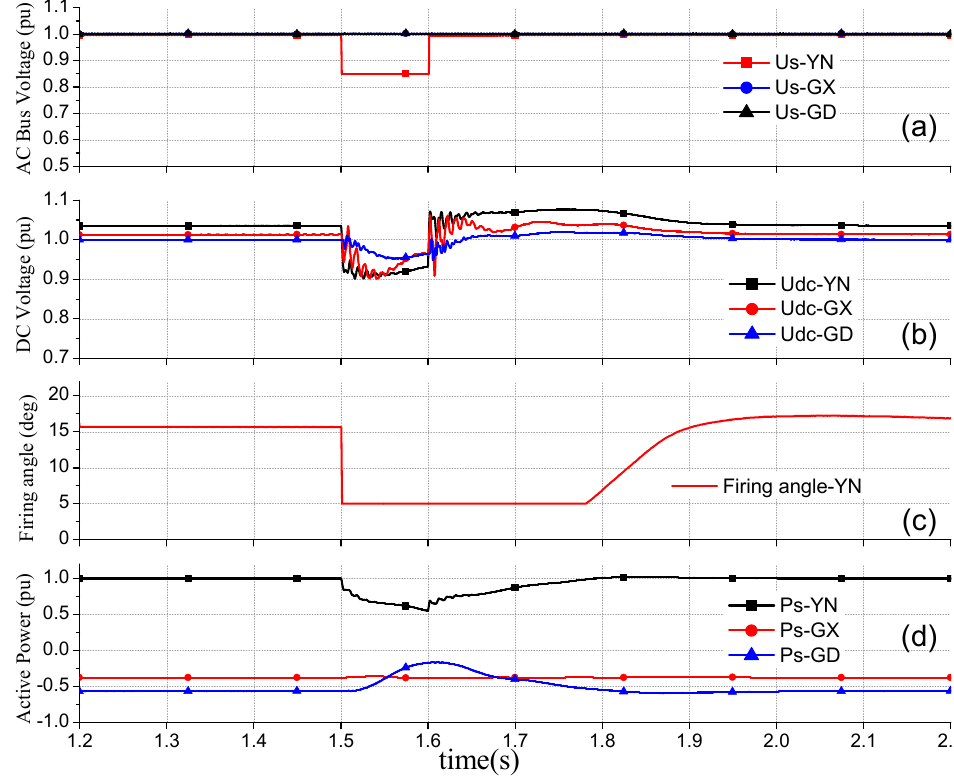
Figure 12. Dynamic performances of the hybrid multi-terminal HVDC system under YN bus fault. ( a ) AC bus voltage; ( b ) DC voltage; ( c ) Firing angle; ( d ) Active power.